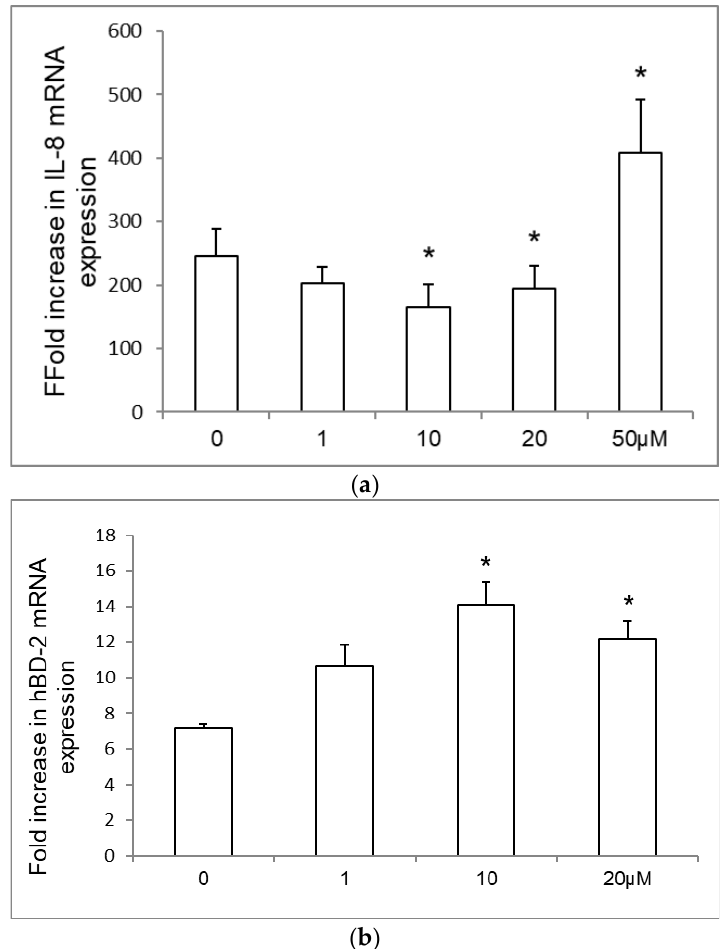
Figure 1. Effect of statins on IL-8 and hBD-2 mRNA expressions in Salmonella -infected SW480 cells. Cultured SW480 cells were uninfected or infected for 1 h with S. Typhimurium wild-type strain SL1344 (SL) in the presence or absence of different simvastatin concentrations (1, 10, 20, 50 μM). Total RNA extracted from the cultured cells after infection was transcribed to cDNA and analyzed by real-time quantitative PCR to estimate the IL-8 and hBD-2 mRNA expressions. The expressions of IL-8 ( a ) and hBD-2 mRNAs ( b ) were normalized to the corresponding GAPDH expression and are shown as fold increases over the uninfected control cells. The results indicate the means and standard deviations for duplicate wells from at least three separate experiments (* p < 0.05 compared to Salmonella infection only).